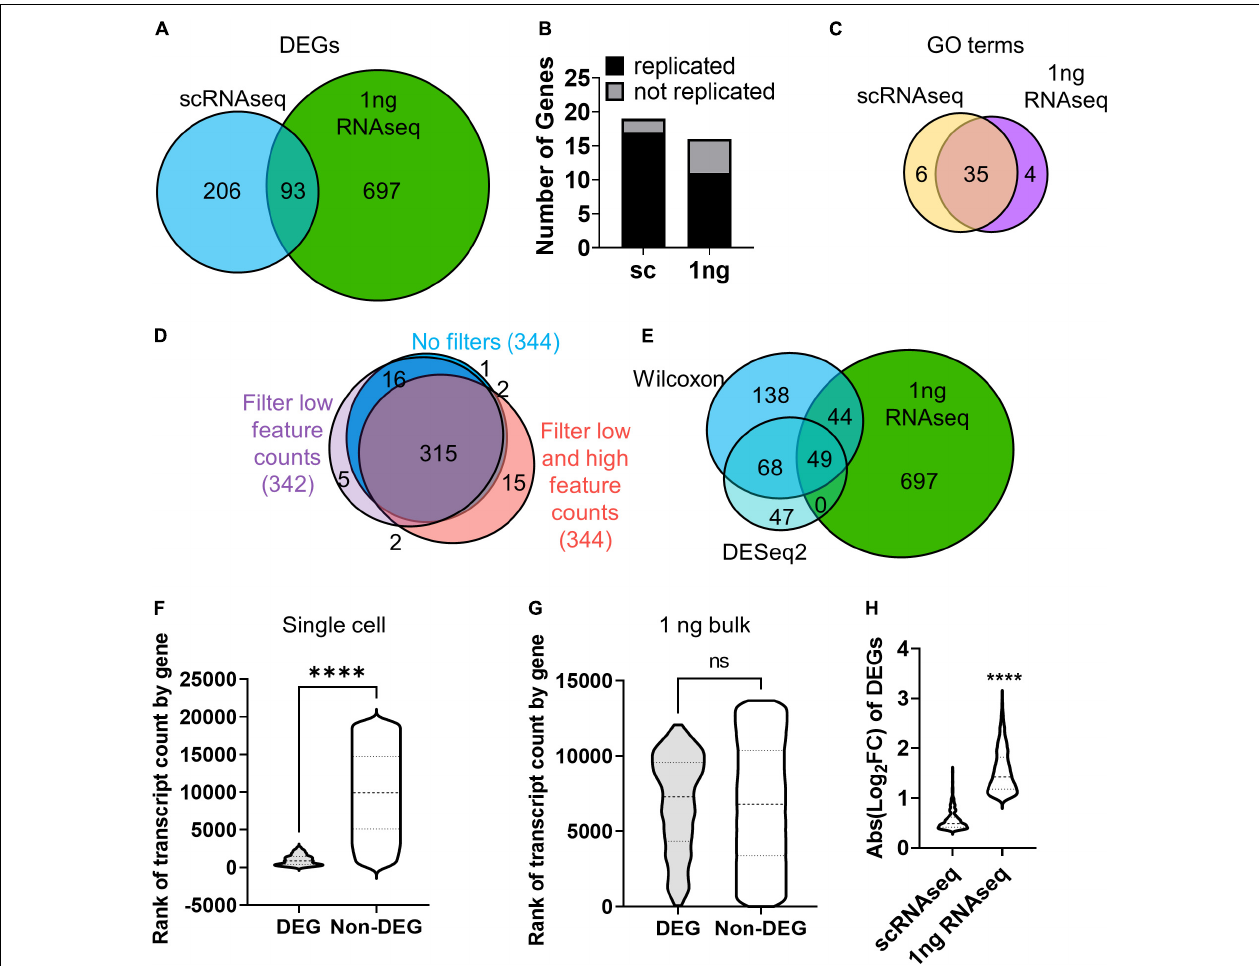
FIGURE 3 | RNA input leads to bias in DEG discovery. (A) Venn diagram of DEGs identified by scRNAseq and 1 ng RNAseq with CLEAR filtering after H 2 O 2 vs. vehicle treatment. (B) qRT-PCR analysis corroborated the majority of DEGs identified by scRNAseq and 1 ng RNAseq in cultured NSCs following H 2 O 2 -induced oxidative stress. X 2 contingency test (df = 1) = 2.331, p = 0.127. (C) Venn diagram of GO terms associated with DEGs identifies by scRNAseq and 1 ng RNAseq. (D) Venn diagram of DEGs identified by scRNAseq with no filtering, filtering for low feature counts, and filtering for both low and high feature counts (i.e., the default for Seurat analysis). (E) Venn diagram of DEGs identified by scRNAseq using the Wilcoxon test or DESeq2 compared with DEGs identified by 1 ng RNAseq. (F,G) DEGs were ranked by average transcript count level relative to all detected gene counts. (F) Violin plot of genes ranked by transcript count level in scRNAseq dataset. DEGs ranked significantly higher in transcript count compared to non-DEGs. ∗∗∗∗ p < 0.0001 unpaired t -test. (G) Violin plot of genes ranked by transcript count level in 1 ng RNAseq dataset. There was no significant difference in rank of transcript count between DEGs and non-DEGs. (H) Comparison of fold changes